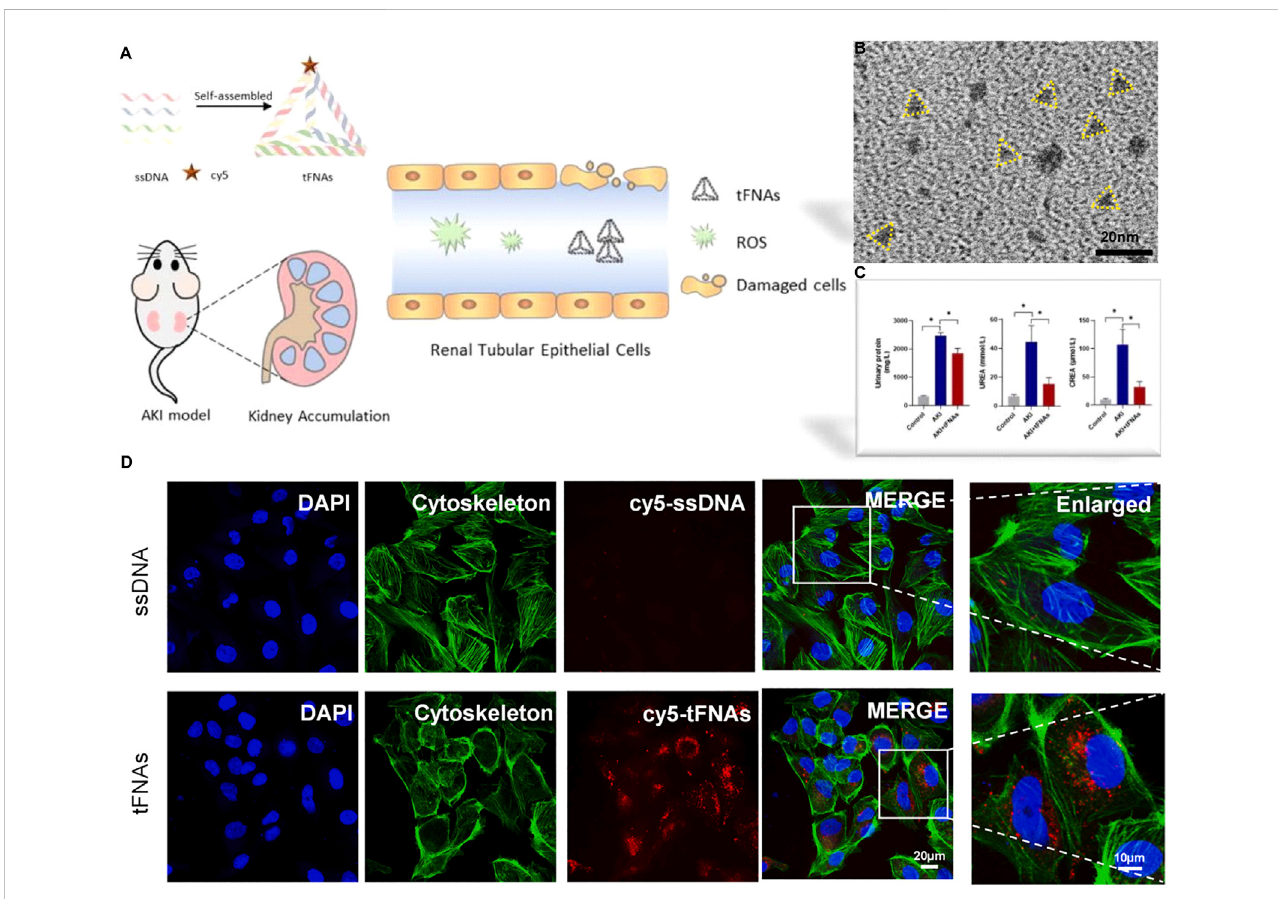
FIGURE 5 (A) Schematic illustration of tFNAs treating RM-induced AKI. TFNAs can reduce the oxidative stress and inhibit apoptosis by targeting renal tubular epithelialcells,showingkidneyaccumulationandalleviatingkidneyinjury; (B) RepresentativeTEMimagesoftFNAs; (C) Analysisofvariousfactorsandlevelsof AKI model mice before and after administration; (D) The uptake of Cy5-tFNAs and Cy5-ssDNA by HK-2 cells. Adapted with permission from (Chem. Eng. J., 2021, 413, 127426.) (Zhang Q. et al.,